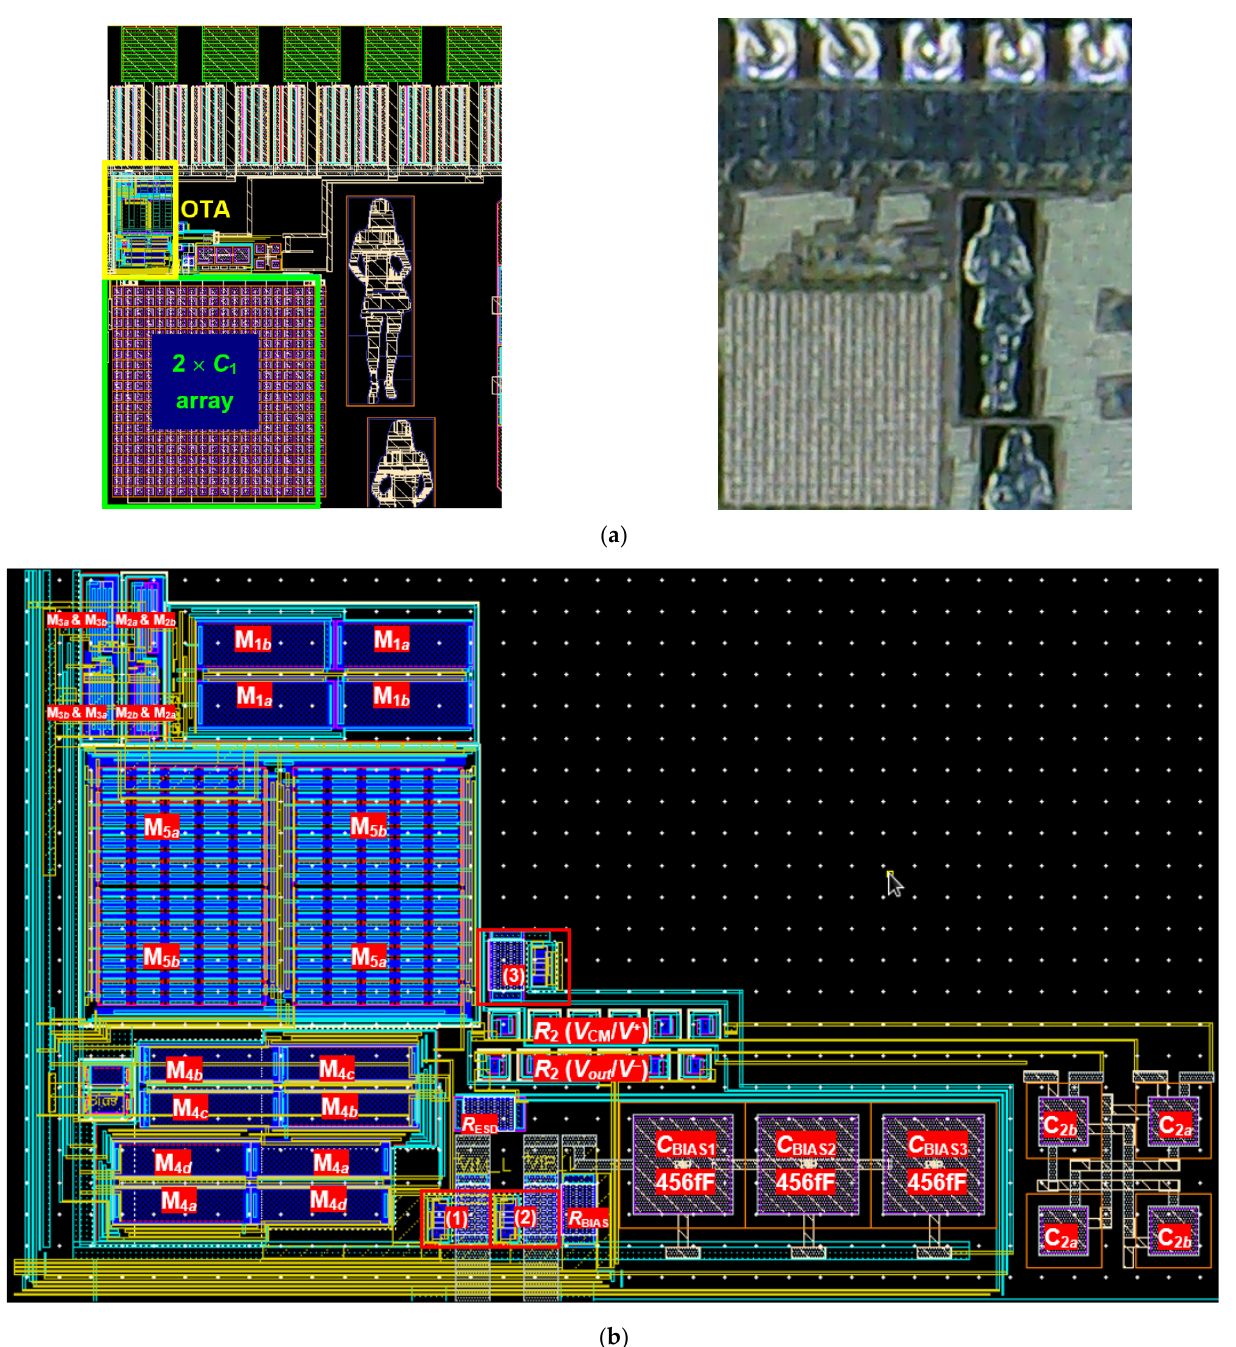
Figure 5. ( a ) Layout of the complete LNA side by side with the respective photograph, with a reference to the OTA and to the array of two capacitors C 1 . ( b ) Zoomed view of the layout of the LNA without the array of capacitors C 1 for a better visualization.